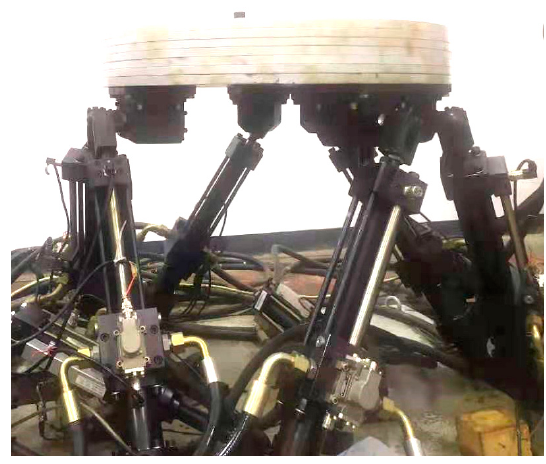
Figure 8. Structure diagram of the experimental platform.